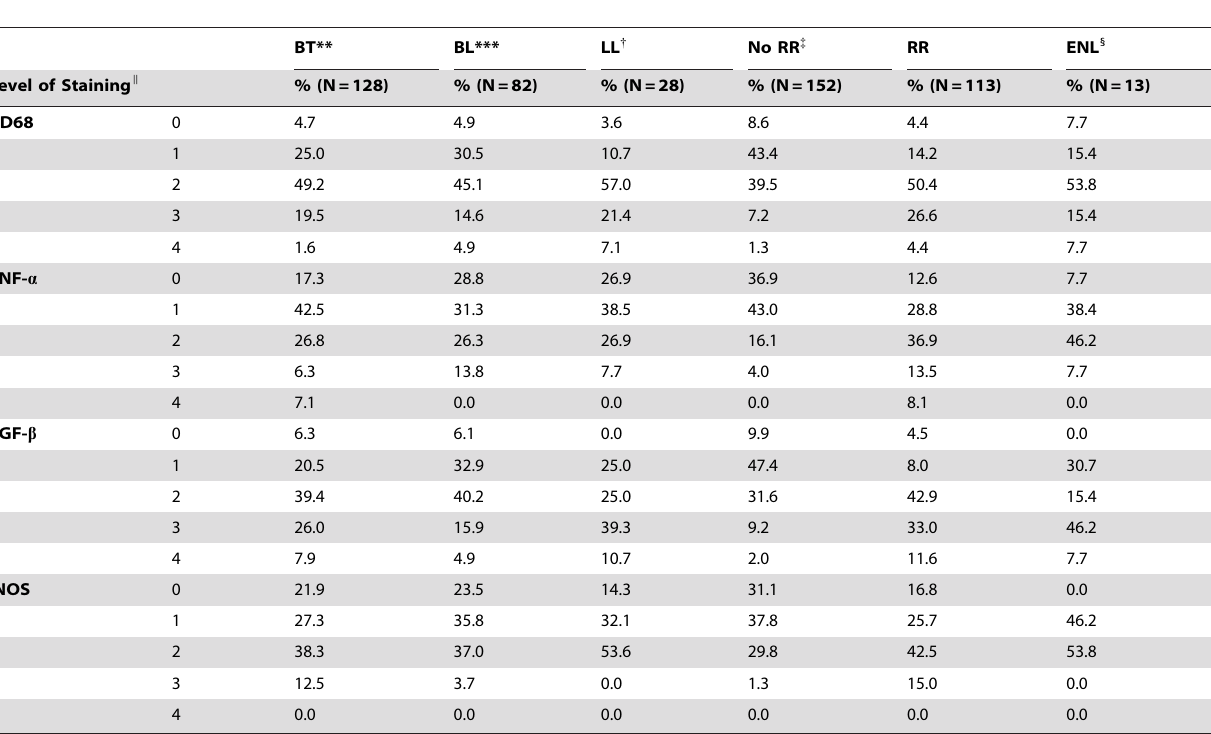
*Figures are rounded to 1 decimal place. **Borderline tuberculoid leprosy; ***Borderline lepromatous leprosy; { Lepromatous leprosy; { Reversal reaction. 1 Erythema Nodosum Leprosum;